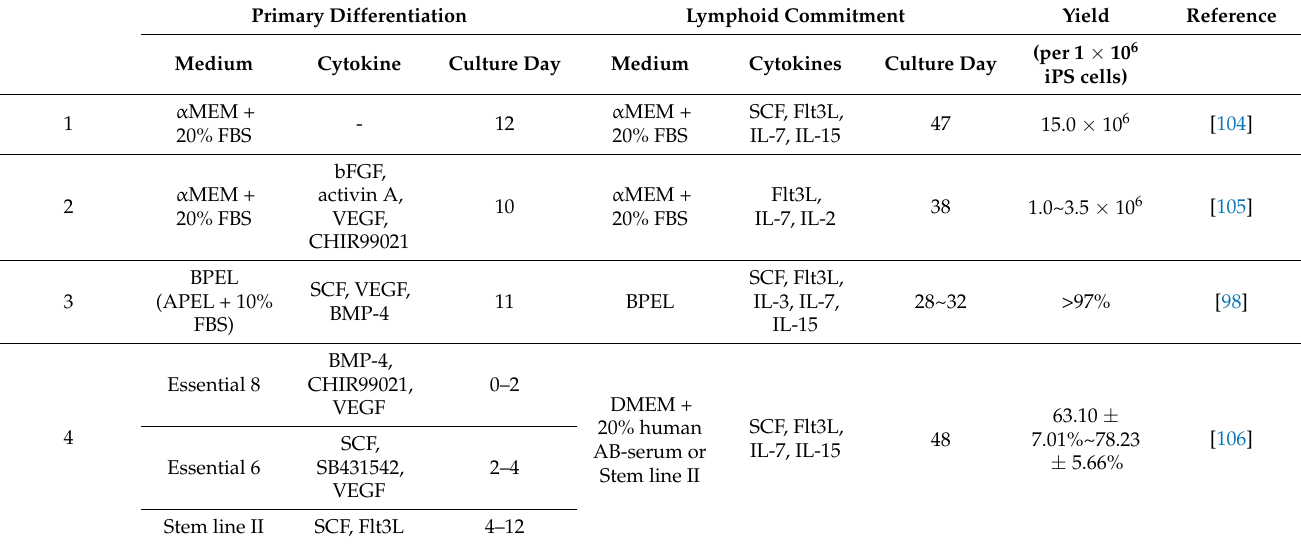
Table 1. Generation methods for iPSC-derived NK